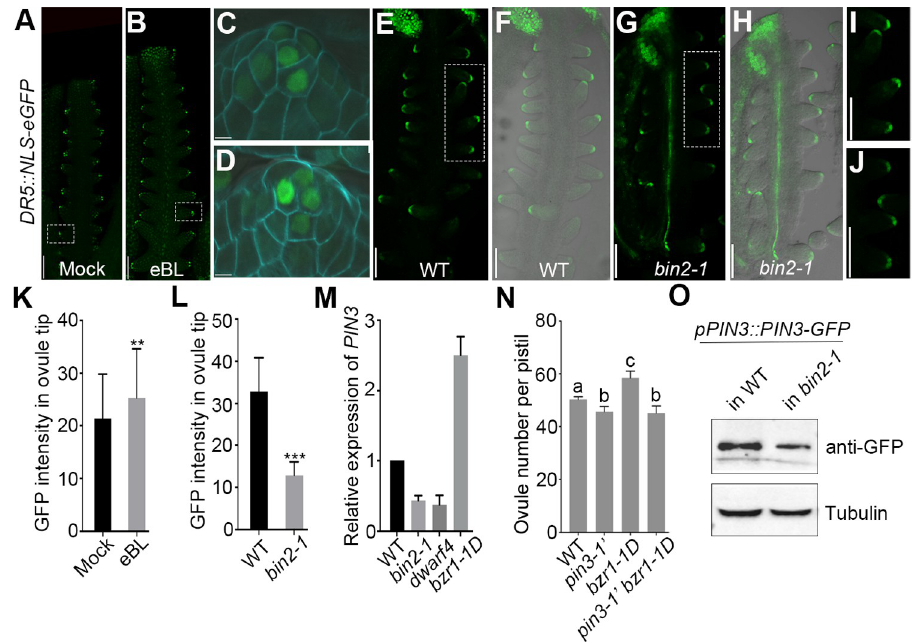
Fig 7. BR enhances auxin signal in the ovule tip and affects PIN3 expression during ovule initiation. (A-D) Increased DR5 signal in ovule tips at floral stage 9 detected in DR5 :: NLS-eGFP line upon BR treatment. Magnified views of the ovules in (A) and (B) indicated by the dotted rectangle are shown in (C) and (D), respectively. Flowers were treated with the mock solution (A) or 2 μ M eBL (B) for 24 h. (E-J) DR5 signal in ovule tips at floral stage 10 of the wild-type (E,F,I) and bin2-1 (G,H,J) backgrounds. Magnified views of the ovules in (E) and (G) outlined by the dotted rectangle are shown in (I) and (J), respectively. (K-L) Quantification of GFP intensity in ovule tips under BR treatment (K) and in bin2-1 mutant (L). (M) Expression analysis of PIN3 in BR-related mutants. Three biological experiments were performed with similar results showing a time data. (N) Ovule number per pistil in the wild-type, pin3-1’ , bzr1- 1D and pin3-1’ bzr1-1D plants. (O) PIN3-GFP protein levels in the pistils of the wild-type and bin2-1 mutant. Western blot was performed using anti-GFP antibody. Tubulin was severed as an internal control. Bars: 50 μ m (A-J). Data are presented as the mean ± SD (n = 20). Significant differences were revealed by one-way ANOVA ( �� P < 0.01, ��� P < 0.001). Different lowercase letters in (N) indicate the significant differences (P <